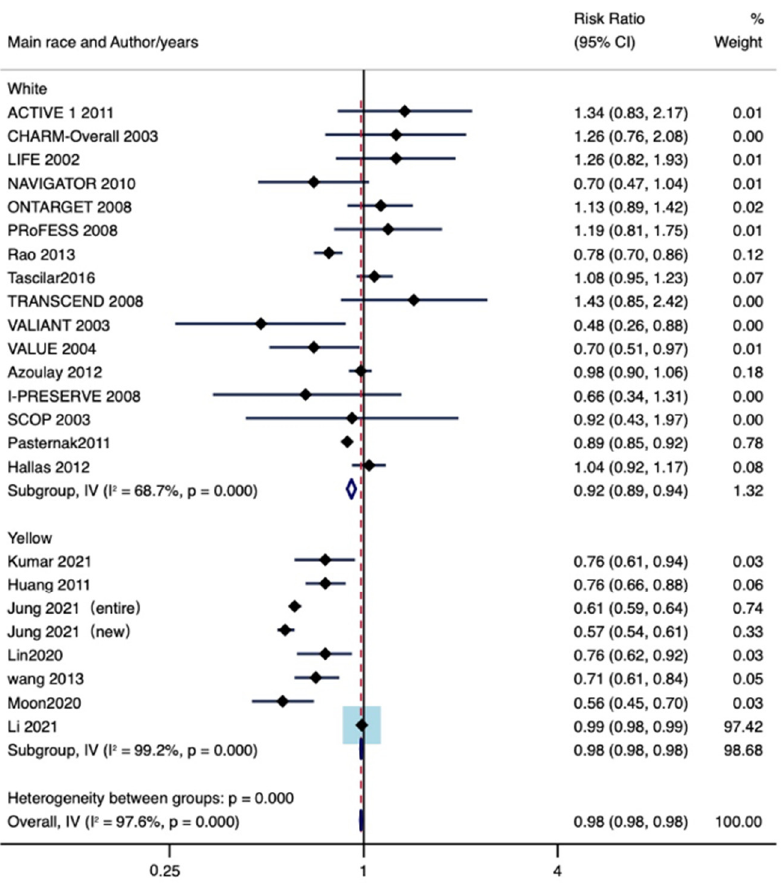
Figure 10. Subgroup analysis by main race.